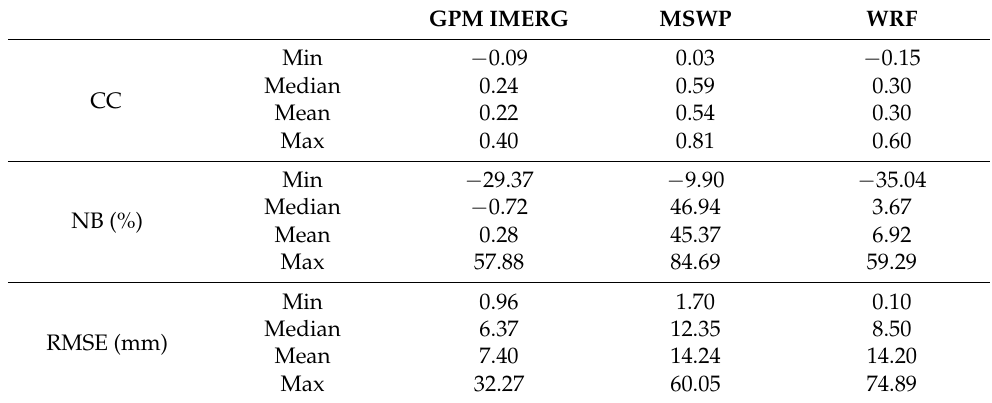
Table 3. The average statistic values of precipitation products comparing the Peruvian rain gauge data from 2010/01 to